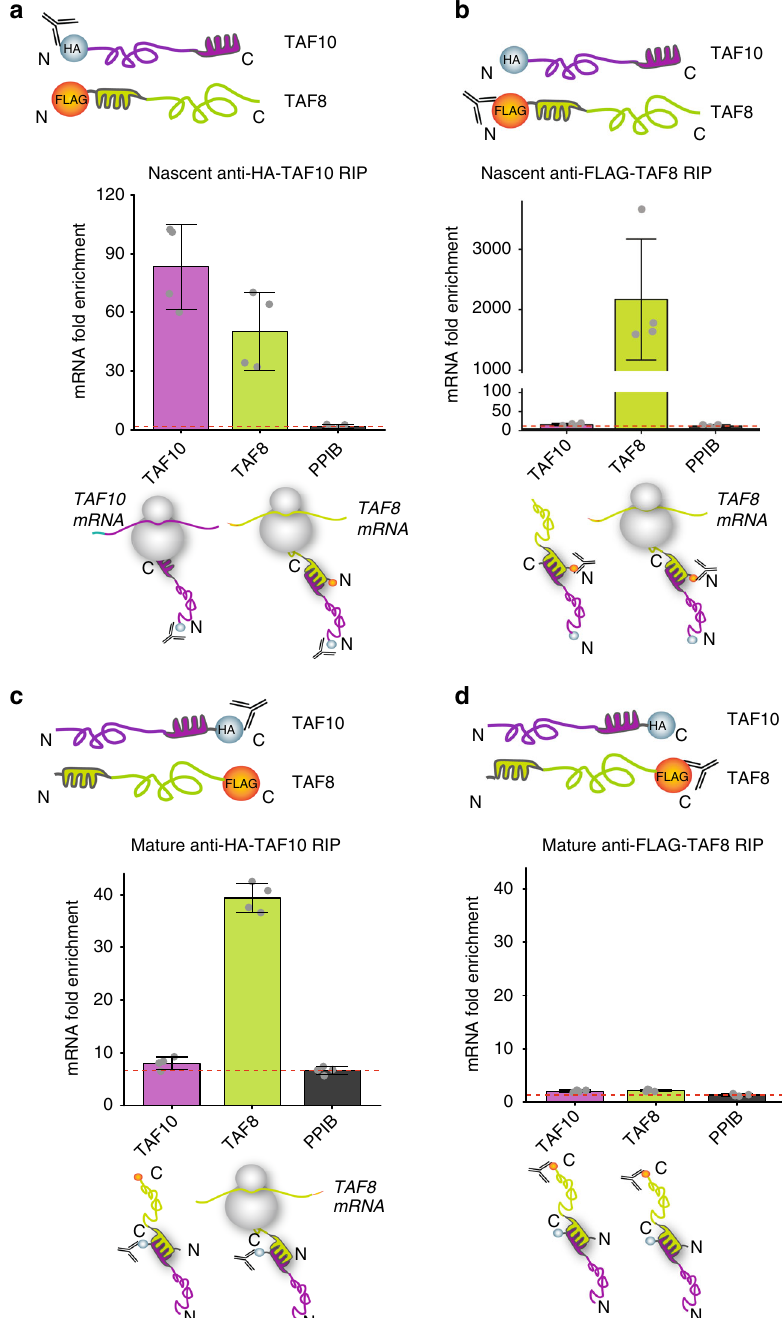
Fig. 2 Sequential assembly of TAF10 and TAF8. N-terminal ( a ) and C-terminal ( c ) anti-HA RIP-qPCR of HeLa cell polysome extracts, co-transfected with the corresponding TAF8 and TAF10 expression plasmids (as indicated). N-terminal ( b ) and C-terminal ( d ) anti - FLAG RIP-qPCR of HeLa cell polysome extracts, co-transfected with the indicated expression plasmids. PP IB ( a – d ) was used as negative control mRNA. In panels ( a – d ) mRNA fold enrichment is expressed as fold change with respect to the mock IP calculated by the formula ΔΔ Cp [IP/mock] and error bars represent ±SD from two biological and two technical replicates (represented by grey dots). Source data provided as a Source Data